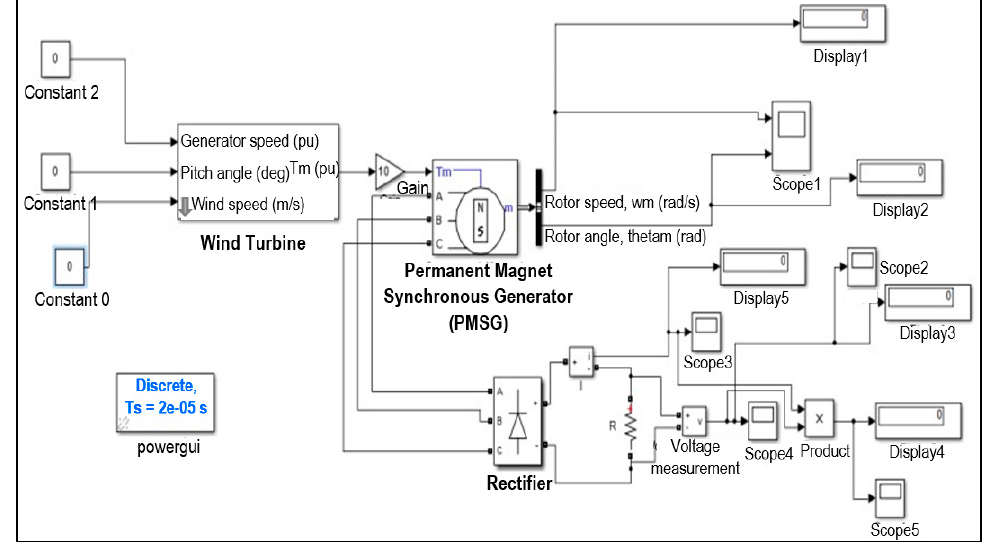
Figure 12. Wind-turbine system without MPPT in Simulink-Matlab software.